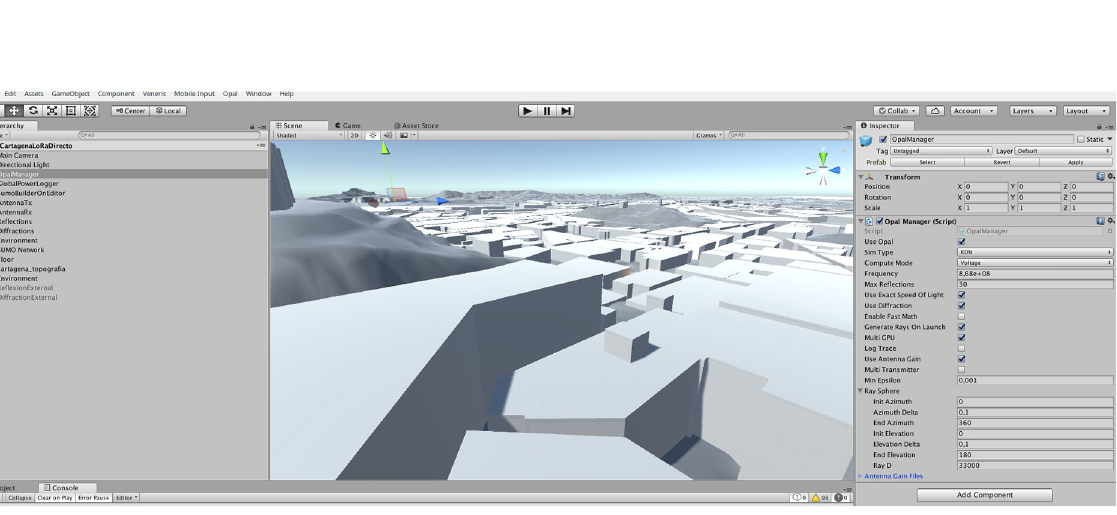
PLOS ONE | https://doi.org/10.1371/journal.pone.0260060 November17,